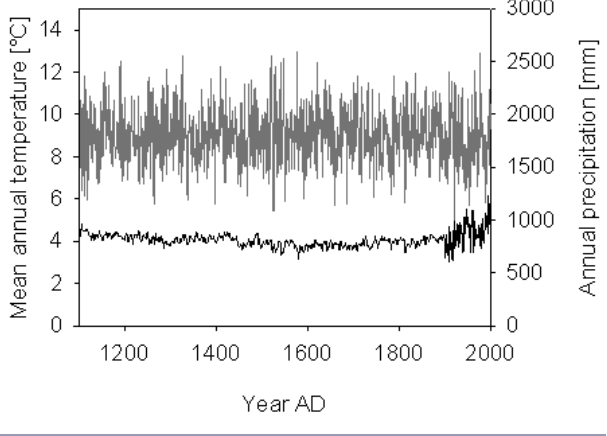
Fig. 2 . Time series of historical climate (yearly values) used for simulation of the pasture’s history since the Middle Ages. Temperature: black; precipitation: grey. Dendrochronological reconstruction of temperature is from 1100 to 1900 AD (Moberg et al. 2005), and regionalized observations are from 1900 to 2000. The abrupt change in temperature variability in 1900 is an artifact, which results from the shift from reconstructed to observed temperature data. Given that this artificial temperature fluctuation is within the variability of the observed time series (see cool years around 1950), we do not expect an unrealistic bias in simulation results.